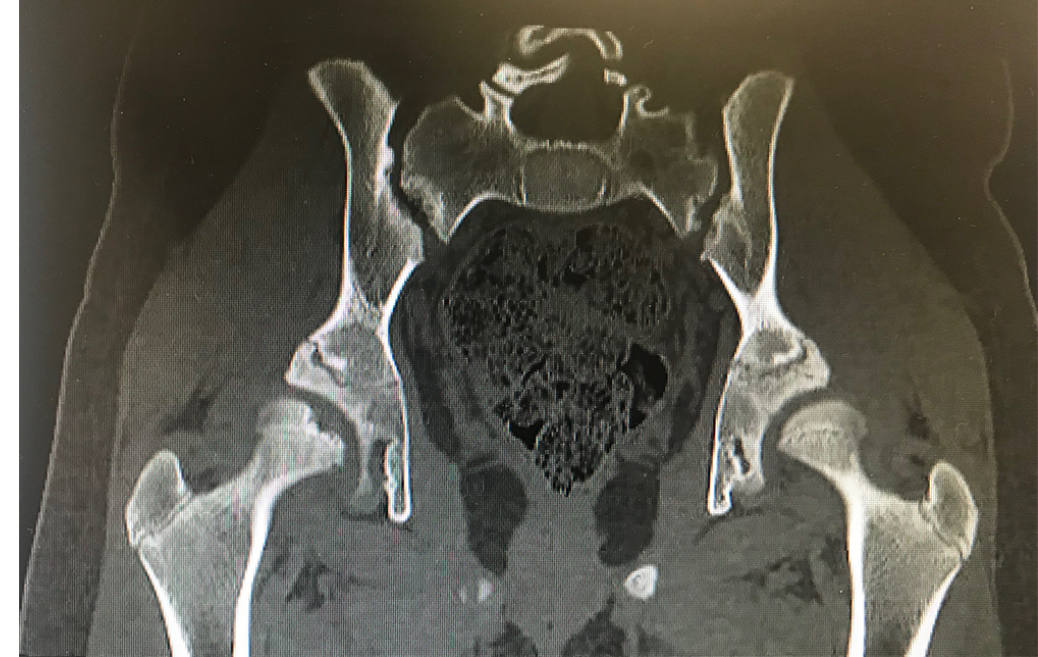
patients. Results from X-ray and magnetic resonance imaging studies.